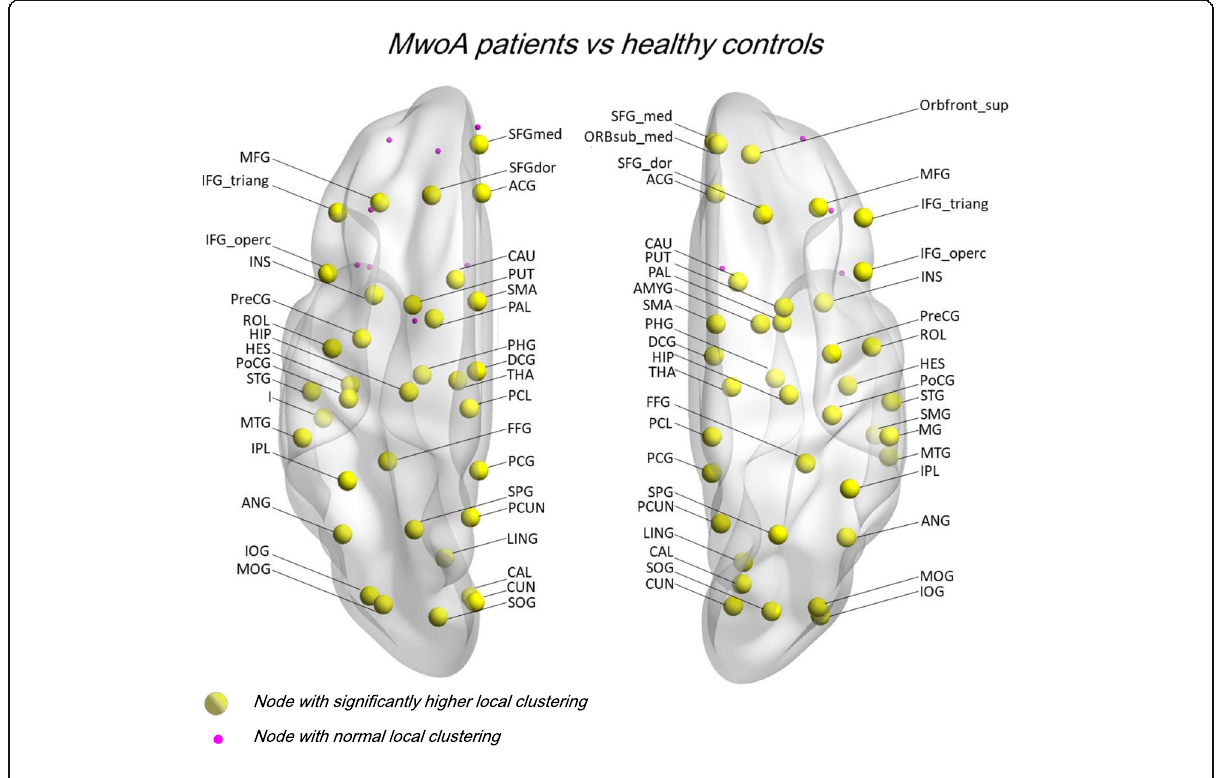
Fig. 2 Representation of nodes with significantly higher local clustering ( t score) in MwoA patients compared to HC data sets ( p < 0.05 corrected for multiple